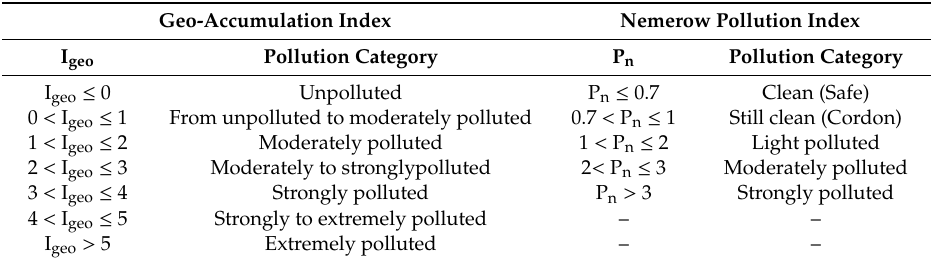
Table 2. Criteria of the pollution grade of soil heavy